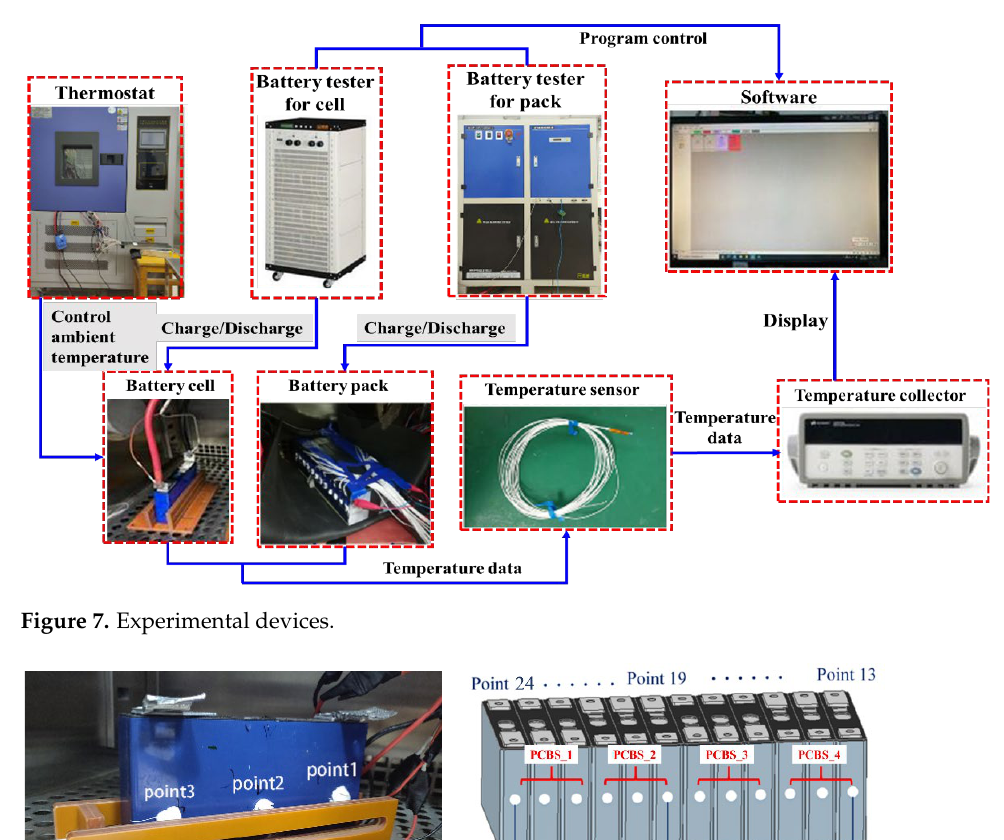
Figure 8. Location of temperature sensor: ( a ) in the cell test, ( b ) in the pack test.